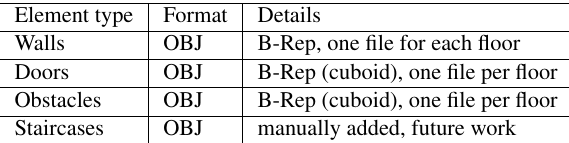
manually added, future work Table 1: The format used to represent the reconstruction result as a sandbox. B-rep means boundary representation (see text), floor is referring to building